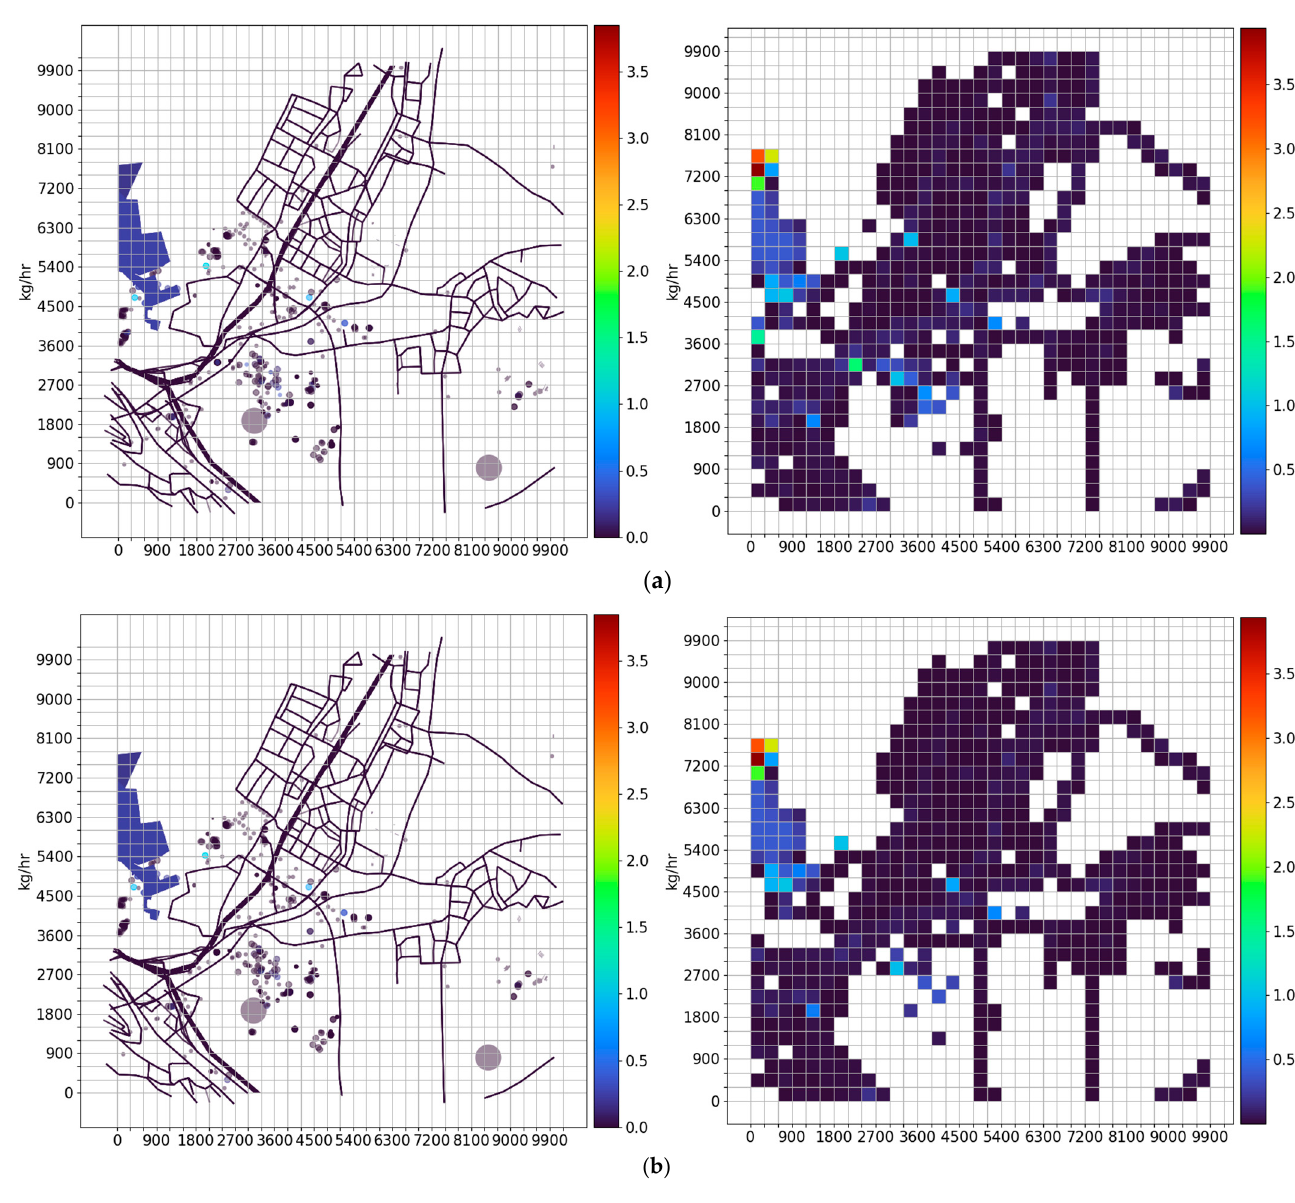
Figure 3. A map of the traffic routes and other pollution sources in the HBA area (left panel) and as areal sources (right panel). The upper ( a ) refer to the sources of PM10 and the lower ( b ) refer to sources of PM2.5.